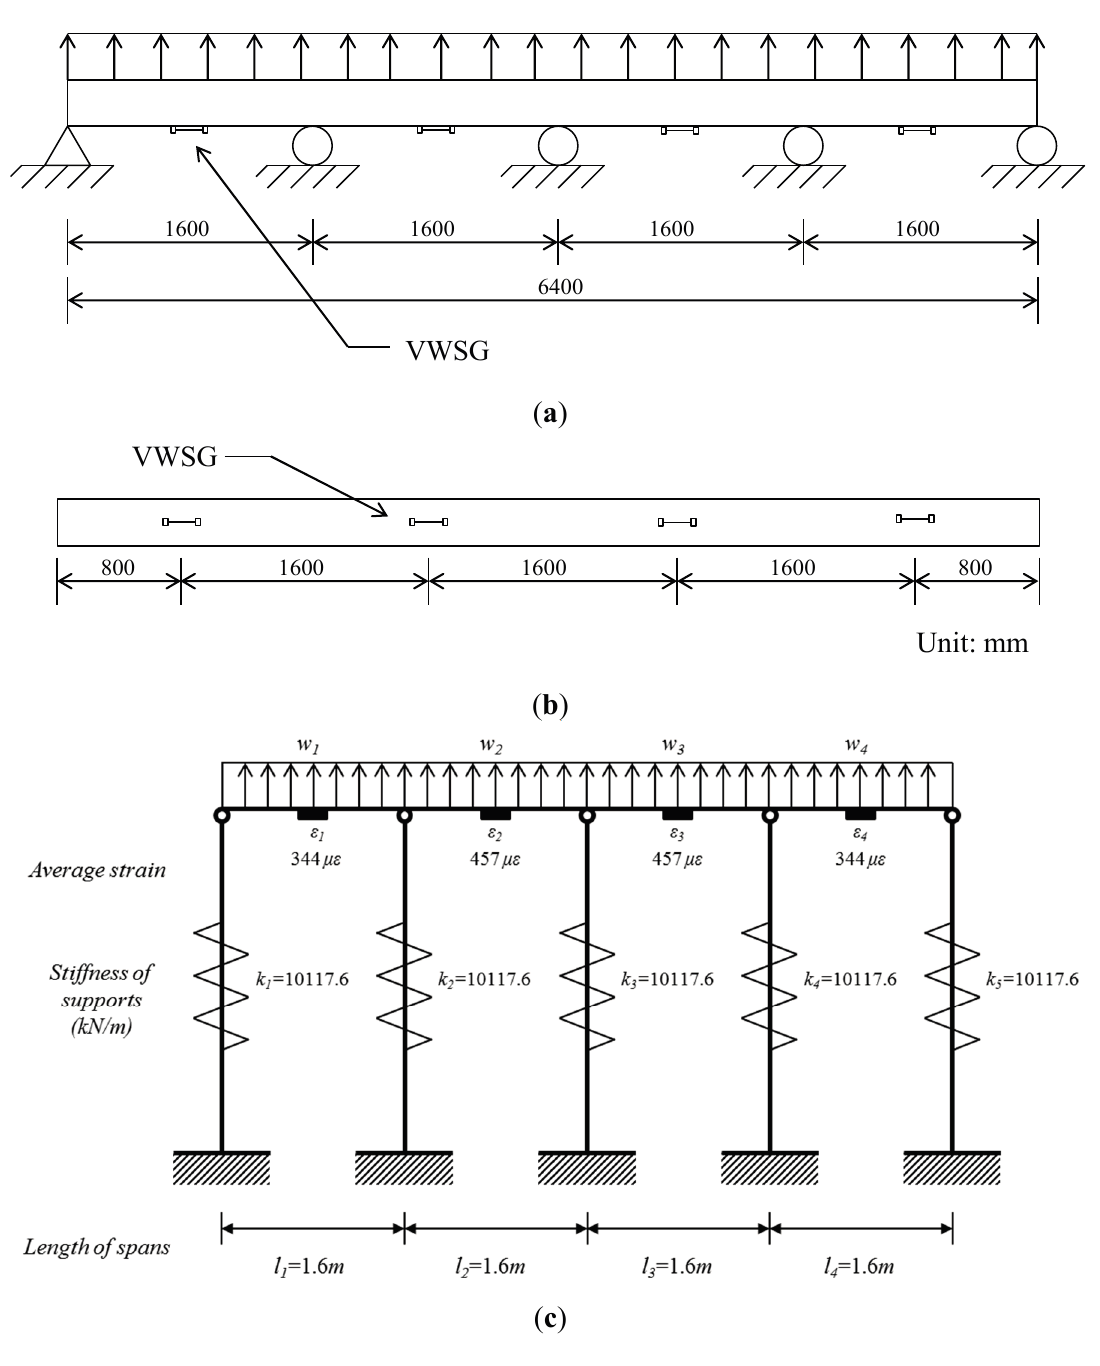
Figure 5. Experimental setup for the test of 4-span beam: ( a ) Side view; ( b ) Bottom view; ( c ) Conceptual